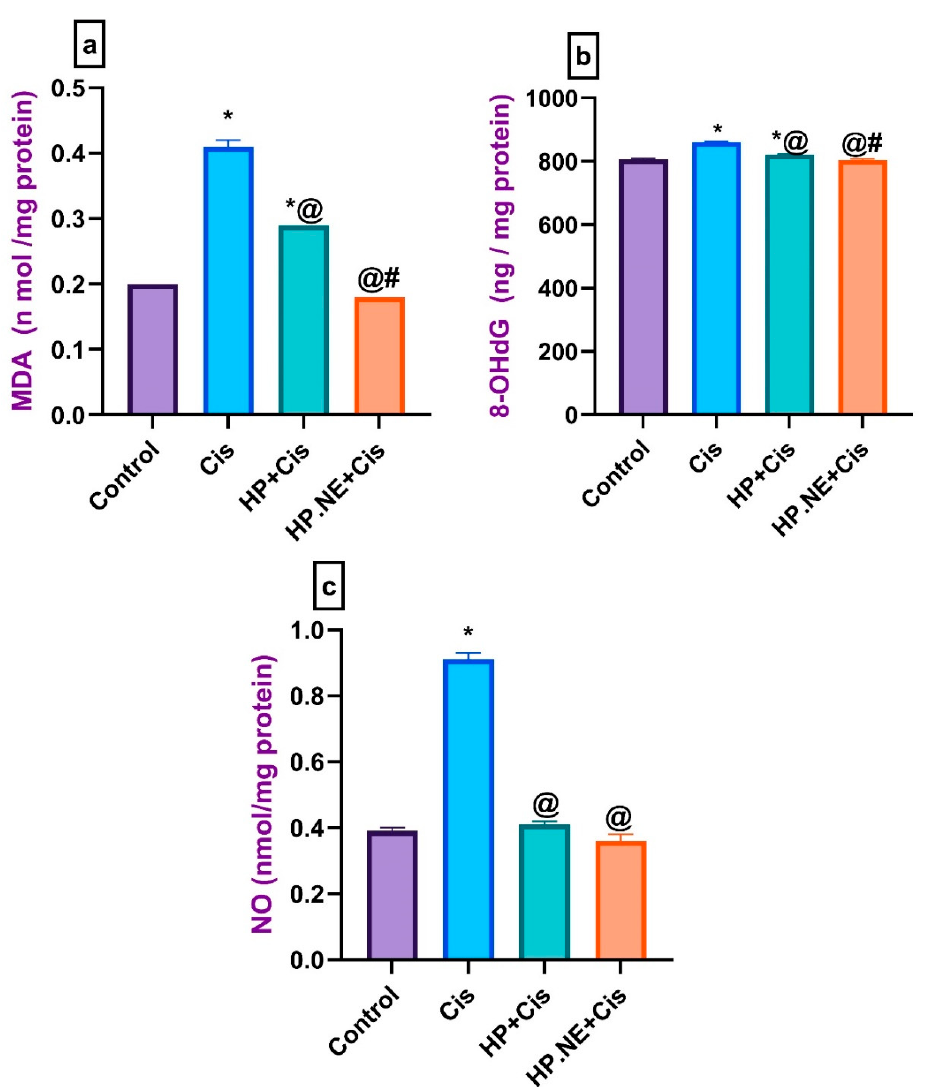
Figure 4. Effect of HP L. and HP.NE administration on the brain levels of malondialdehyde, 8- hydroxy-20-deoxyguanosine, and nitric oxide for different groups. ( a ) MDA: malondialdehyde, ( b ) 8- OHdG: 8-hydroxy-20-deoxyguanosine, and ( c ) NO: nitric oxide. Data are expressed as mean ± SE (one-way ANOVA) followed by Tukey’s post hoc test for seven rats in each group. * means significant from the Control group; @, significant from the Cis group; #, significant from the HP + Cis group.